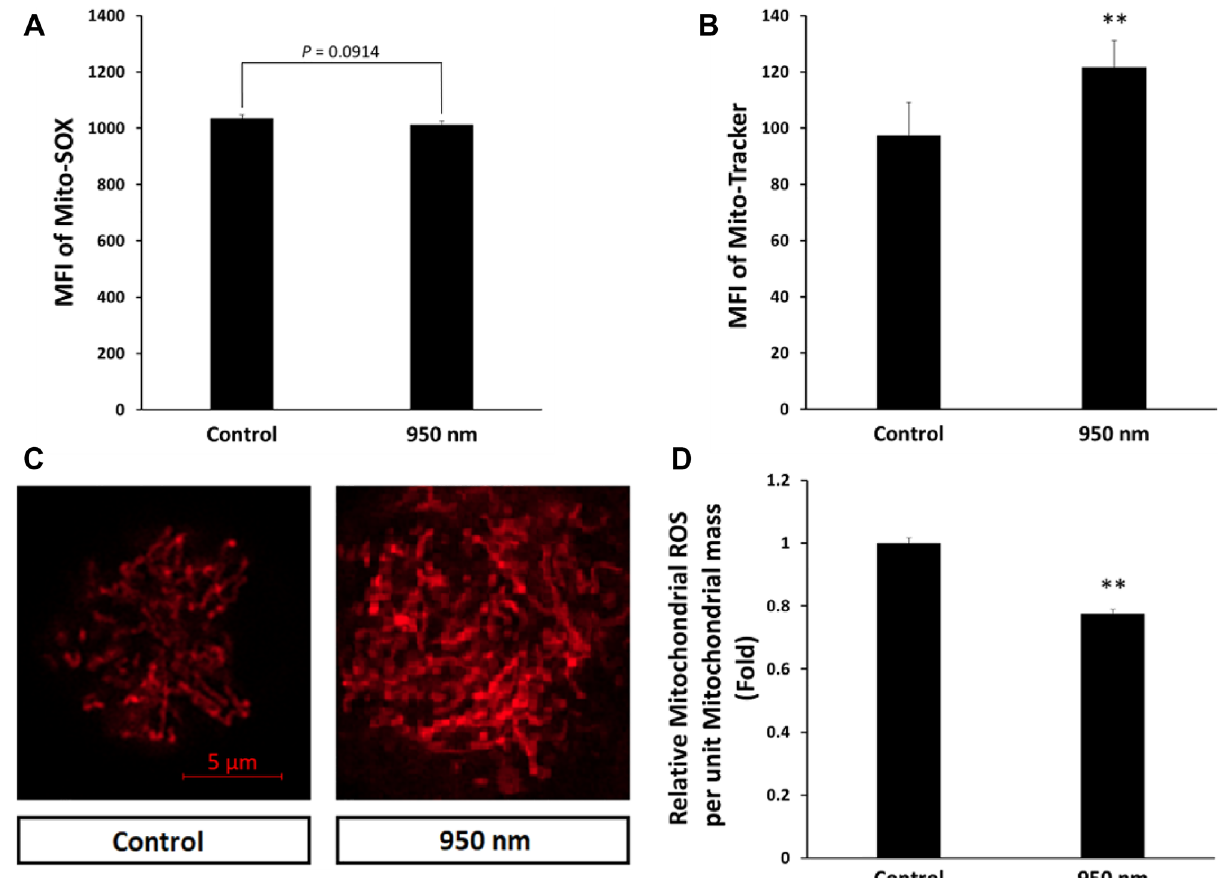
Figure 4. Decreased mitochondrial ROS by 950 nm NIR irradiation. ( A ) MFI of Mito-SOX (mitochondrial ROS) was slightly reduced. The two groups did not show a significant difference. Data are mean ± SD (n > 5). P = 0.0914 compared to control. ( B ) MFI of Mito-Tracker (mitochondrial mass) was significantly enhanced. ( C ) Typical confocal microscopic images of Mito-Tracker-stained cells. ( D ) Relative amount of mitochondrial ROS per unit mitochondrial mass. To compare the ROS in each treated group with that of the control group, the MFI of Mito-SOX was divided by that of the Mito-Tracker. The two groups showed a significant difference. Data are mean ± SD (n > 5). ** P < 0.01 compared to controls. P values were determined by one-way ANOVA ( A–D